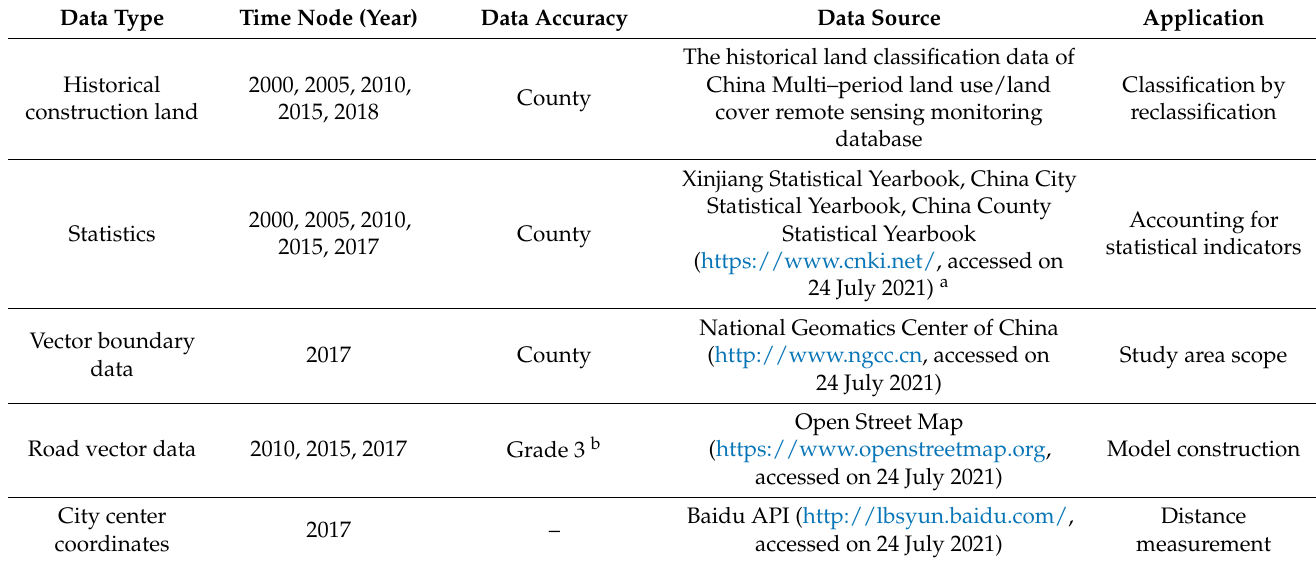
Table 1. Data types and